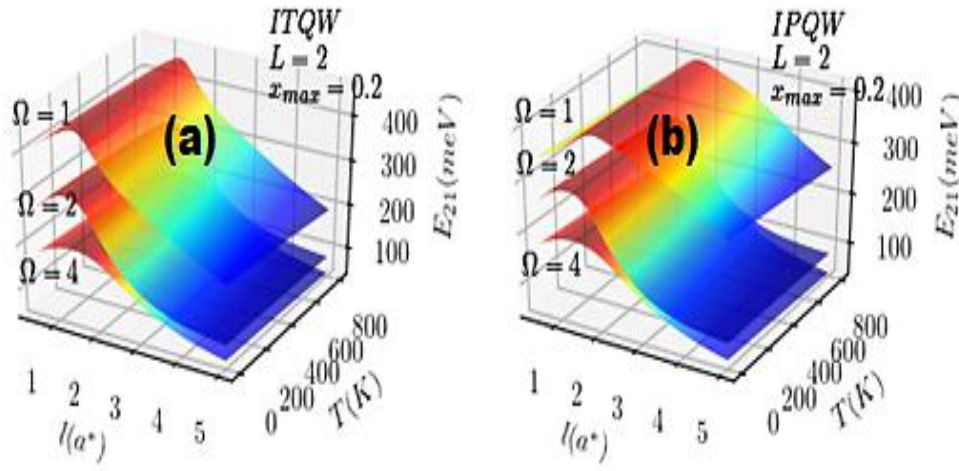
Figure 2: The variation of the three low-lying energy levels in both ITQW (a) and IPQW (b) versus the well width (x-axis) and temperature (y-axis) with a fixed barrier width (L=2) and x three different values of